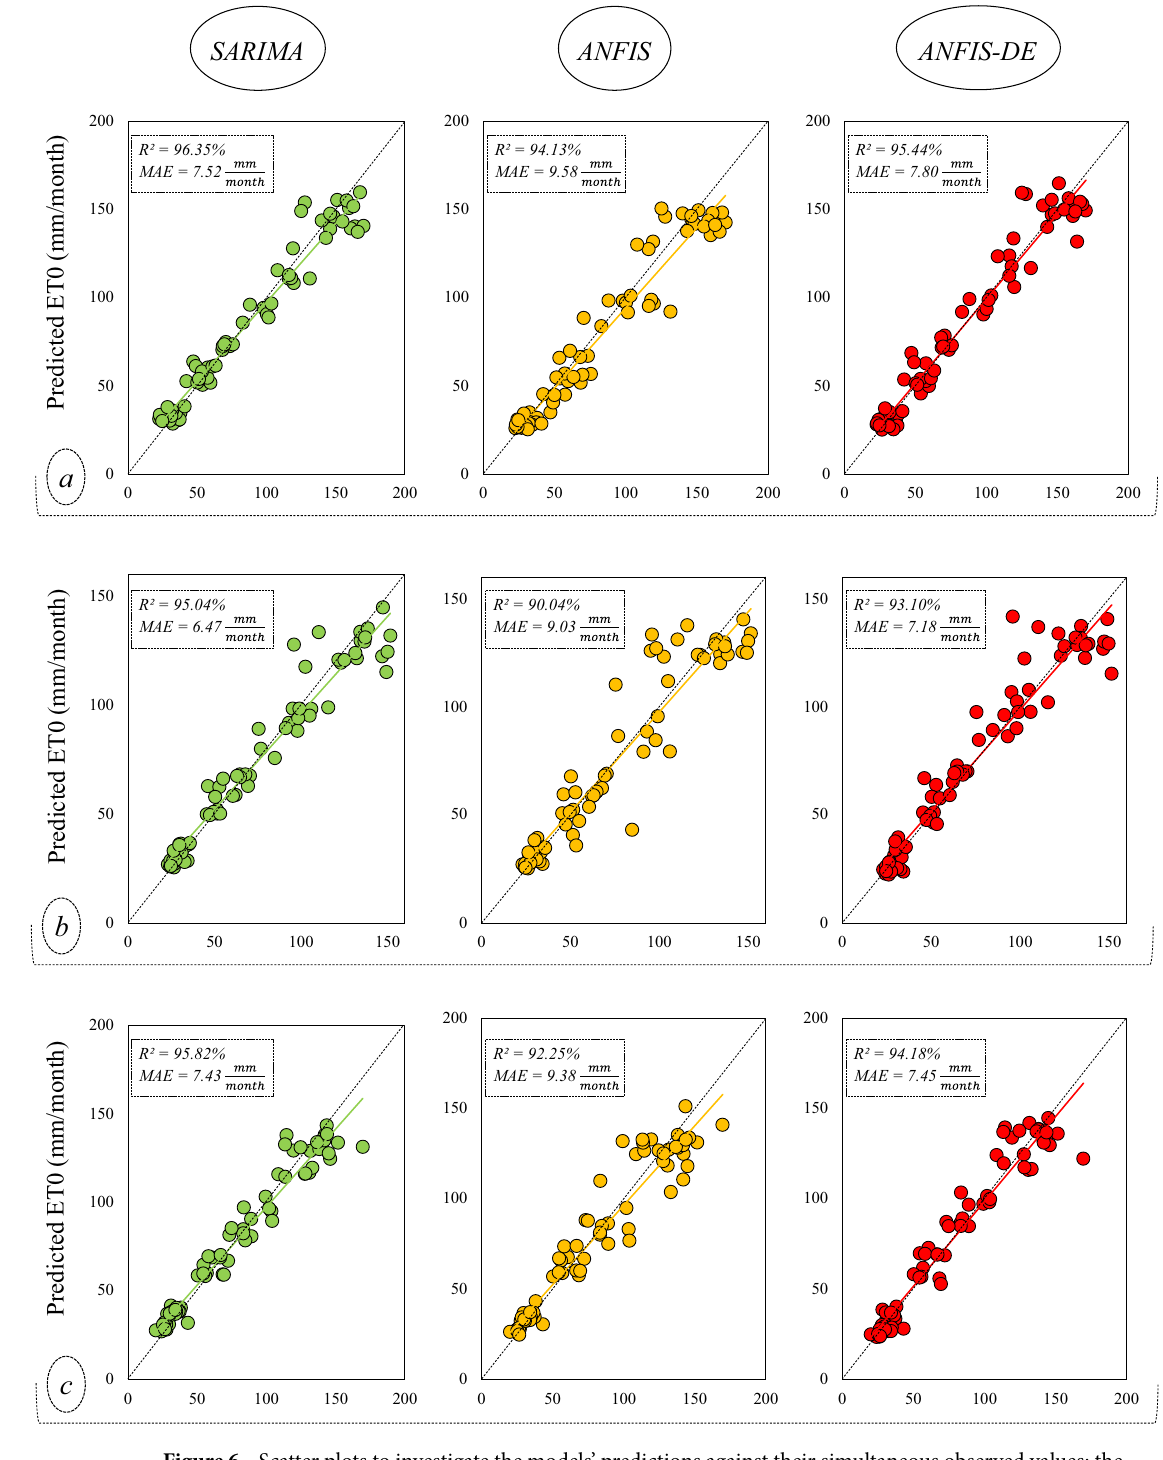
Figure 6. Scatter plots to investigate the models’ predictions against their simultaneous observed values; the alphabets within the brackets refer to the stations: ( a ) Bandar Anzali, ( b ) Ramsar, ( c ) Gharakhil, ( d ) Ahwaz, ( e ) Shiraz, ( f )